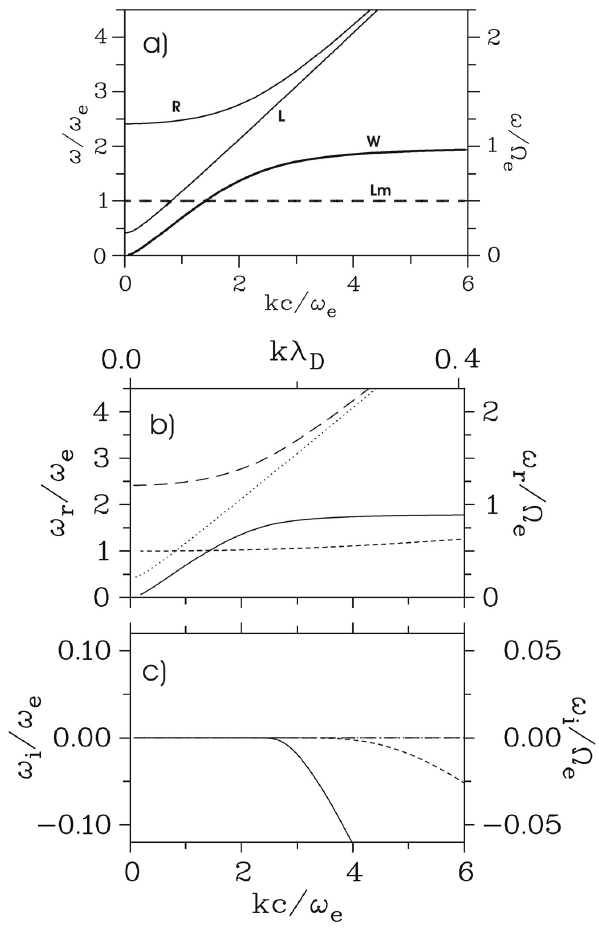
Fig. 1. Dispersion branches for parallel propagating waves, G = 2. (a) Cold plasma theory, the four modes are the Langmuir mode (Lm), the whistler mode (W), the L-mode (L) and the R-mode up- per branch (R); (b) real and (c) imaginary part of frequency versus wave number from Vlasov approach using β e = 0 . 002. The real frequencies of both approaches agree very well. The onset of ki- netic damping of the whistler mode (solid line) for kc/ω e > 1 and the Langmuir mode (dashed line) in regions kλ D ≥ 0 . 2 ( λ D is the Debye length) is clearly seen.